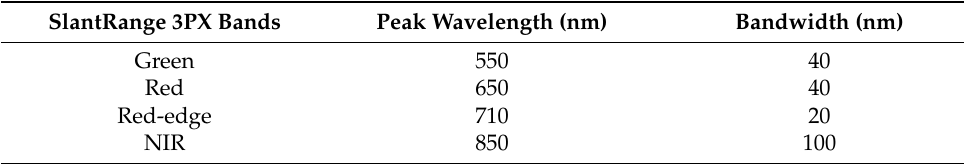
Table 1. Spectral resolution of the SlantRange 3PX sensor used in the study. SlantRange 3PX Bands Peak Wavelength